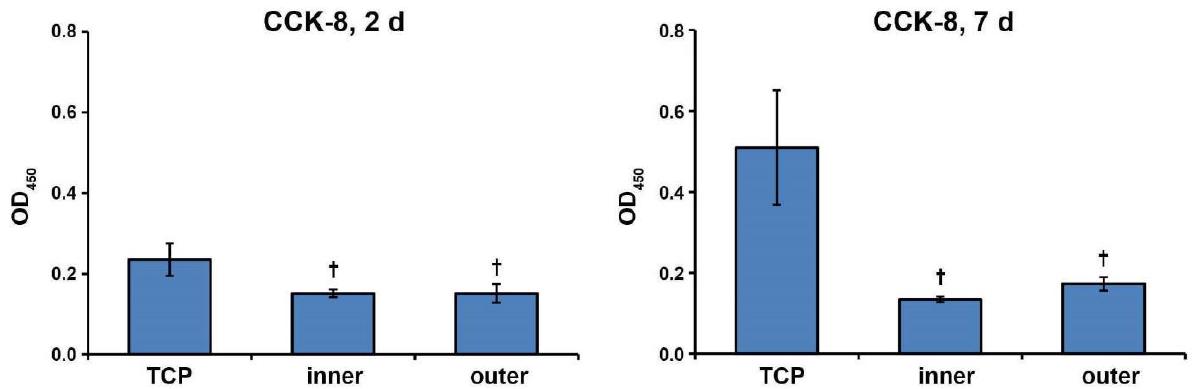
Figure 3. Proliferation/viability of HOKs grown on different aligner surfaces. HOKs were cultured on TCP, inner and outer aligners’ surfaces. Proliferation/viability was measured after 2 and 7 days of incubation by CCK-8 assay. Cells grown on tissue culture plastic served as control. Y -axis represents the optical density (OD) measured at 450 nm. Data represents mean ± S.E.M. of three independent experiments. †—significantly lower compared to control; p < 0.05.